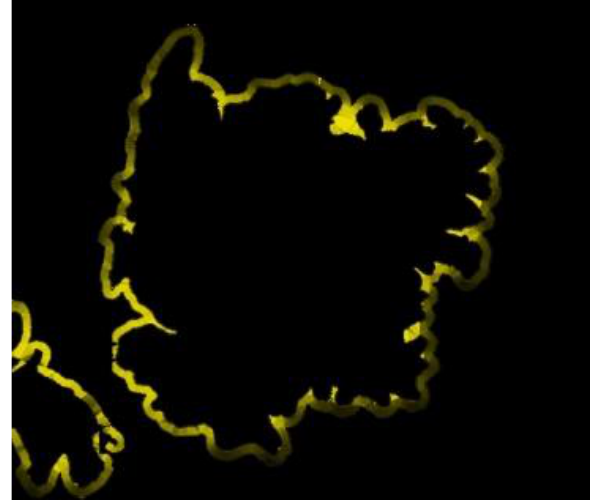
Figure 13. DEM construction by using simple interpolation based on the slope of the two reliefs.